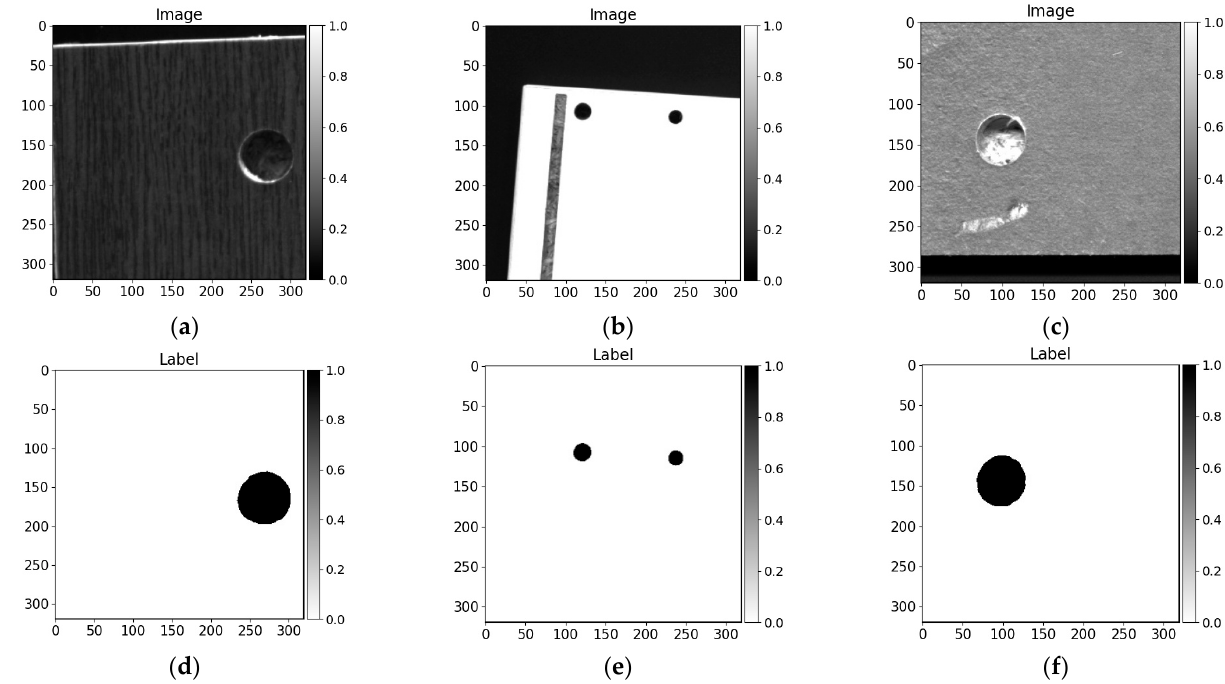
Figure 9. Prepared (cropped) data samples of 320 × 320 px size. All images are scaled to the range [0, 1]. ( a – c ) cropped images, ( d – f ) drilled holed annotations.